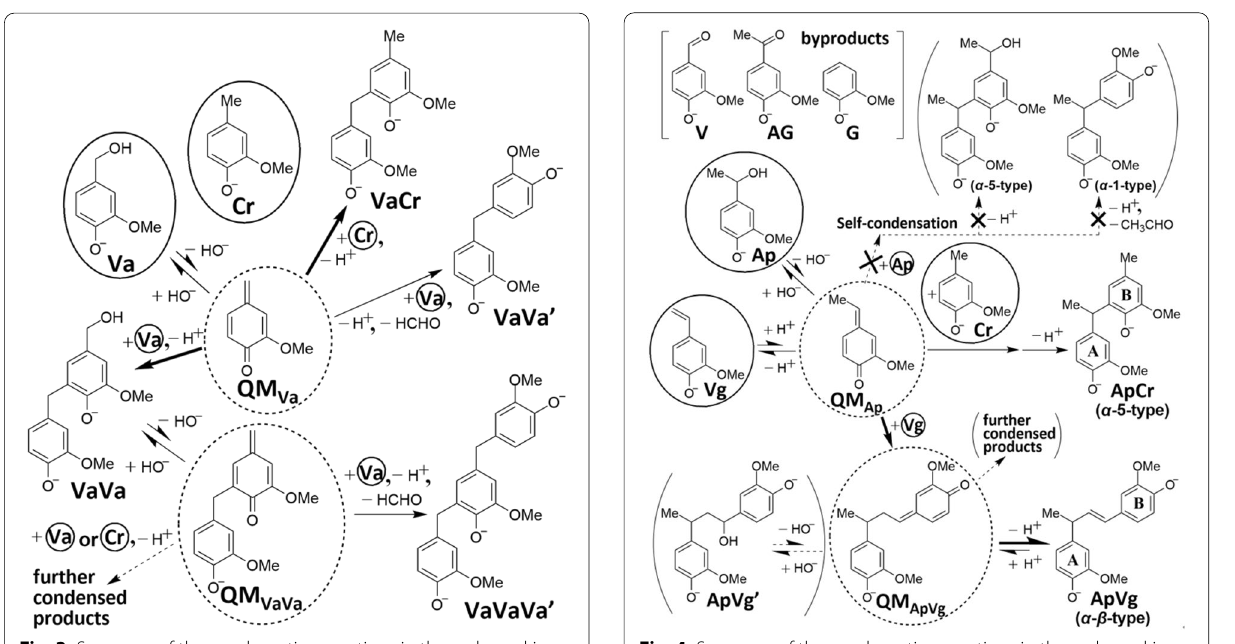
Fig. 3 Summary of the condensation reactions in the soda cooking treatment of Va and Cr observed in our previous reports. [24, 25] The chemical species enclosed by the solid and dotted circles indicate nucleophiles and electrophiles, respectively